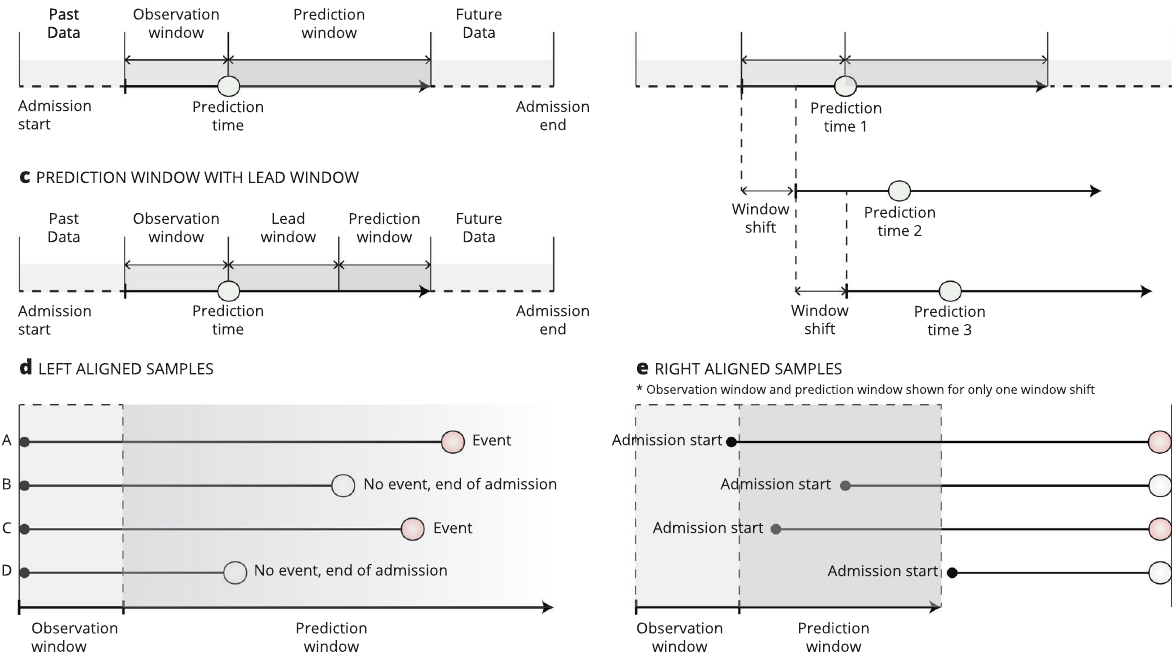
Fig. 1 Basic concepts and terms of framing. a Illustrates prediction time, observation window, and prediction window. Window shift ( b ) is the distance between each prediction. c Shows a variation of ( a ) where the prediction window does not begin immediately after the prediction time but instead shifts to the lead window. d Shows an example of left-aligned samples, where the model is used for predicting fi xed time points, such as admission or preoperatively. e Shows an example of right-aligned samples where all data are considered until some time point before the event of interest (for the positive cases) or the end of admission (for the negative